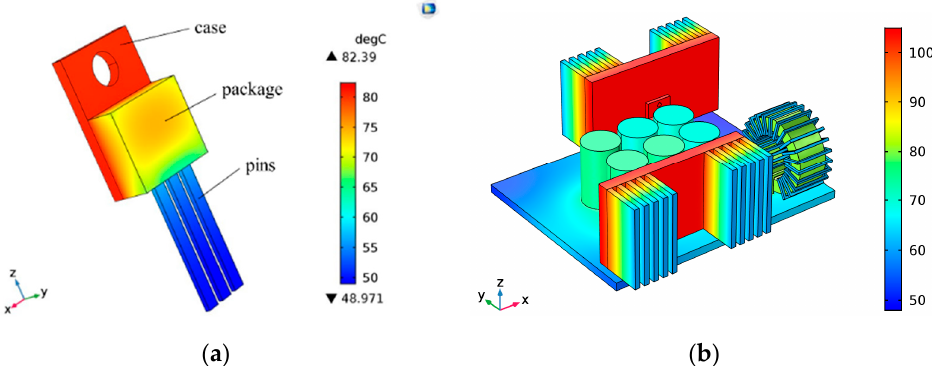
Figure 8. FEM thermal analysis model: ( a ) three-dimensional thermal calculation model for a MOSFET; ( b ) temperature distributions of a power converter. MOSFET; ( b ) temperature distributions of a power converter.